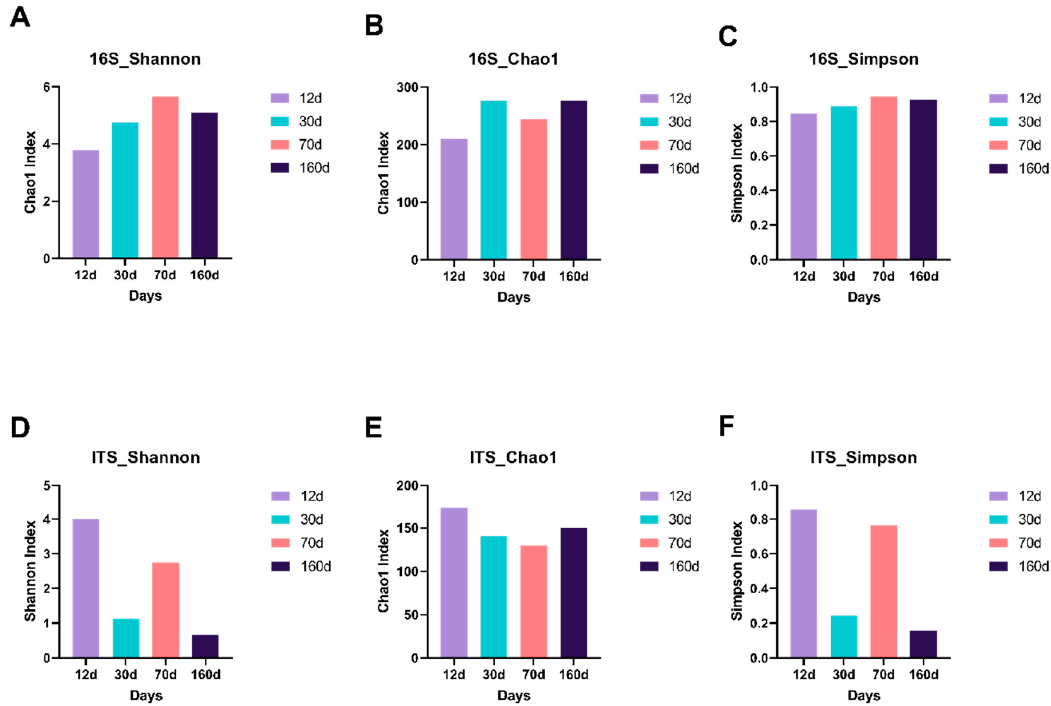
Figure 2. Alpha-diversity indices of the microbial ( A – C ) and mycobial ( D – F ) communities on the surface of dry-aged beef with respect to the aging periods. Alpha-diversity indices are composite indices reflecting abundance and consistency measured on the basis of Shannon, Chao1, and Simpson indices.